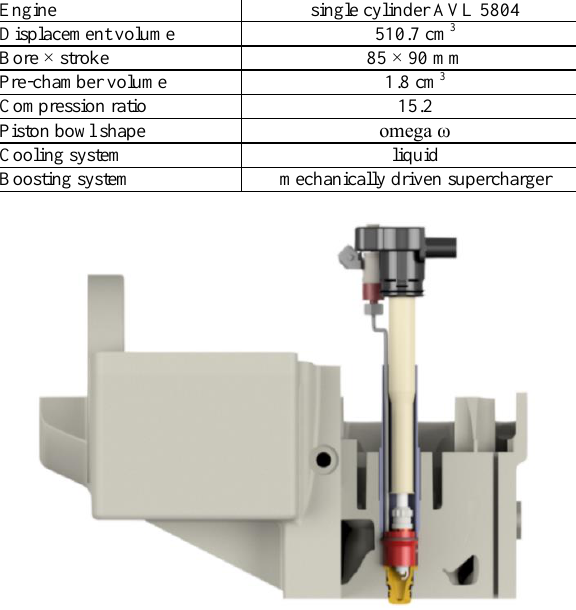
Fig. 1. Cross-section view of jet igniter mounted in AVL 5804 cylinder head